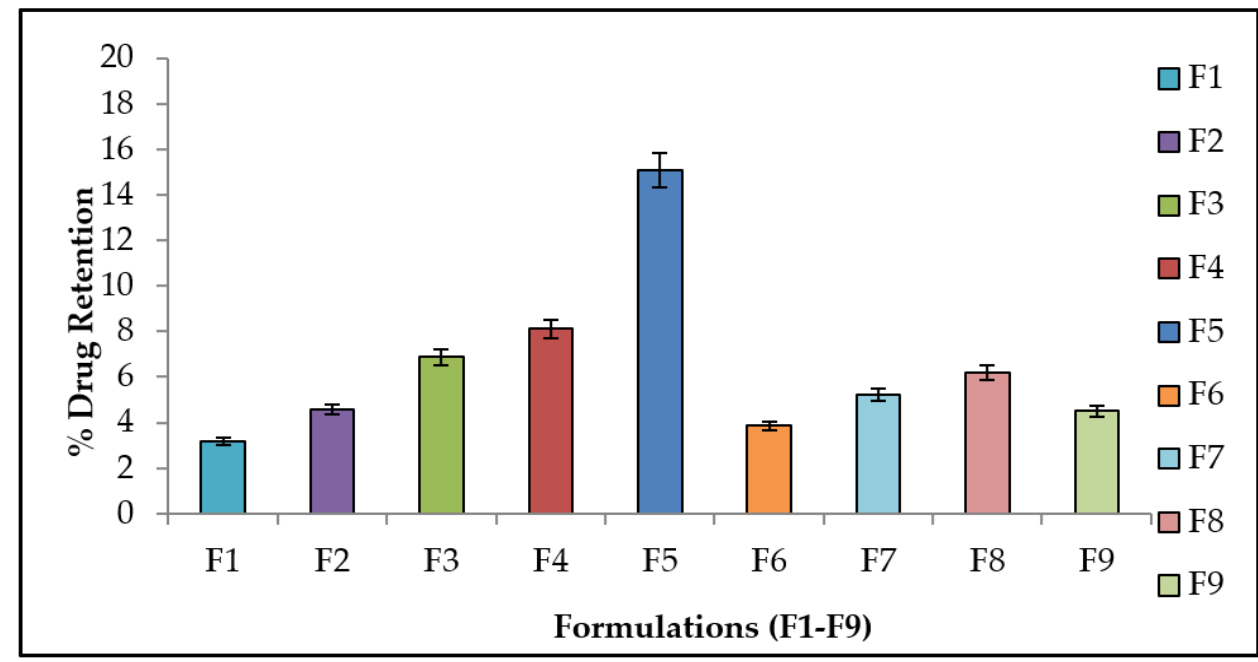
Figure 5. Skin drug retention analysis of methotrexate patches (F1–F9), Data were expressed as mean ± SD, n = 3. Significant compared to formalin (p < 0.05).